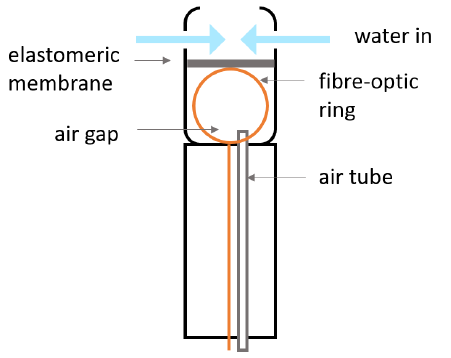
Figure 14. Diagram demonstrating the geometry of an FOS described in